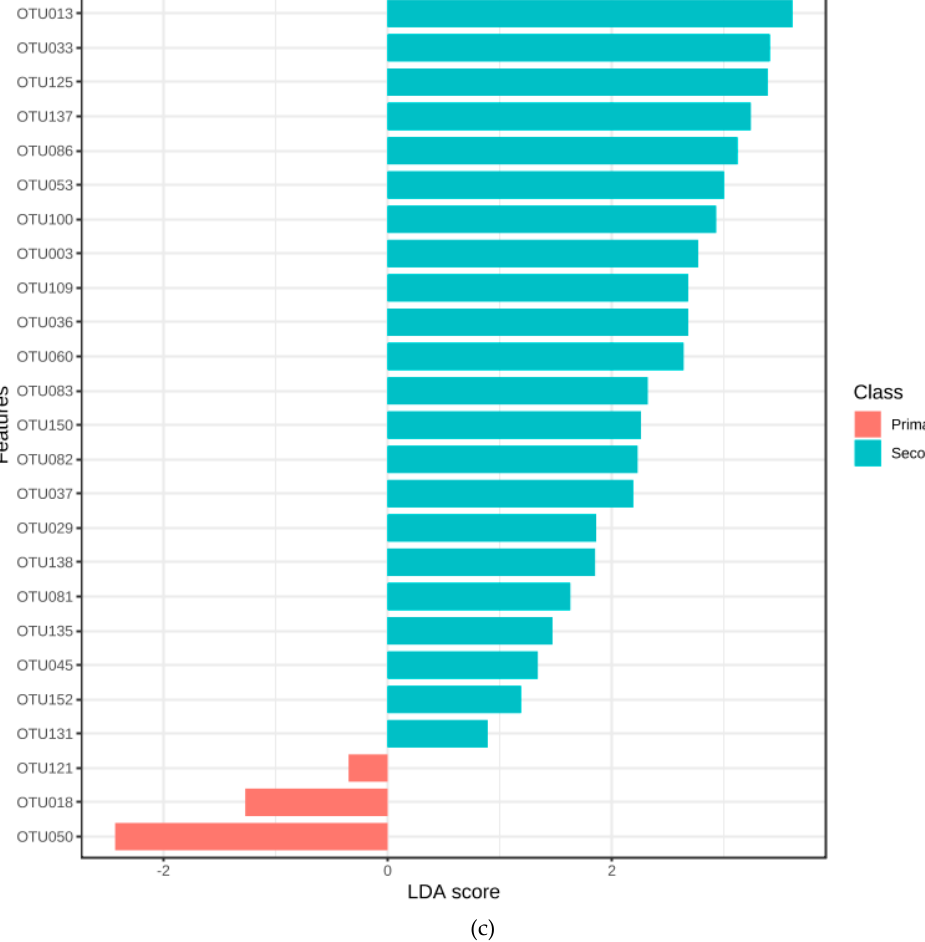
Figure 4. a–c: Differential analysis of primary and secondary endodontic lesions. in primary ( a ) and secondary infections ( b ), demonstrating similar predominant phyla ( Firmicutes and Bacteroidetes ), with shifts resulting in decreased abundance of Proteobacteria and Synergistetes , increased abundance of Actinobacteria , Fusobacteria and Saccharibacteria in the transition to secondary infections; ( c ) Linear Discriminant Analysis (LDA) Effect Size (LefSe) for OTUs selectively enriched for both groups, such as Rothia mucilaginosa (out013), for secondary infections and (non-aureus) Staphylococcus sp. (OTU050), Kingella sp. (OTU121) and Bifidobacterium sp. (OTU018) for primary infections., out OTU identities are provided in Supplementary Table S1.